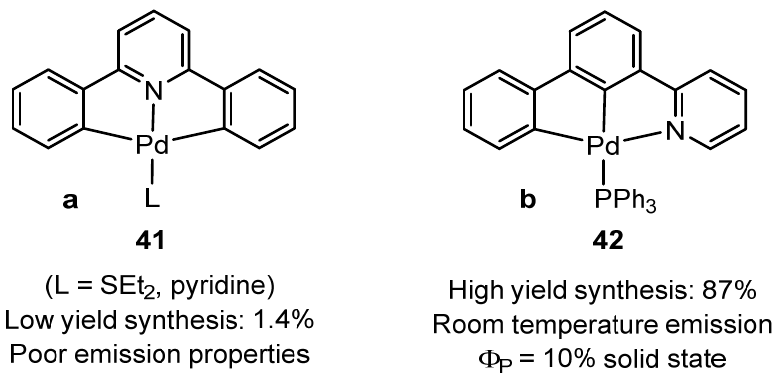
Figure 13. ( a ) Palindromic [(CˆNˆC)Pd(II)] complex 41 and ( b ) non-palindromic [(CˆCˆN)Pd(II)] complex 42 . Adapted from [74,75]. The ligands [2-(2(anthracen-9-ylmethylene)-1-phenylhydrazineyl)pyridine] [76] (Figure 14a) and N , N ’-di-tert-butylbenzene-1,3-dicarbothioamide [77] (Figure 14b) give the fluorescent orthopalladated complexes 43 and 44 , respectively, with Φ = 0.0065 in solution for the former and Φ = 0.05 in powder at room temperature for the latter, slightly higher than the value in the free ligand (4%).